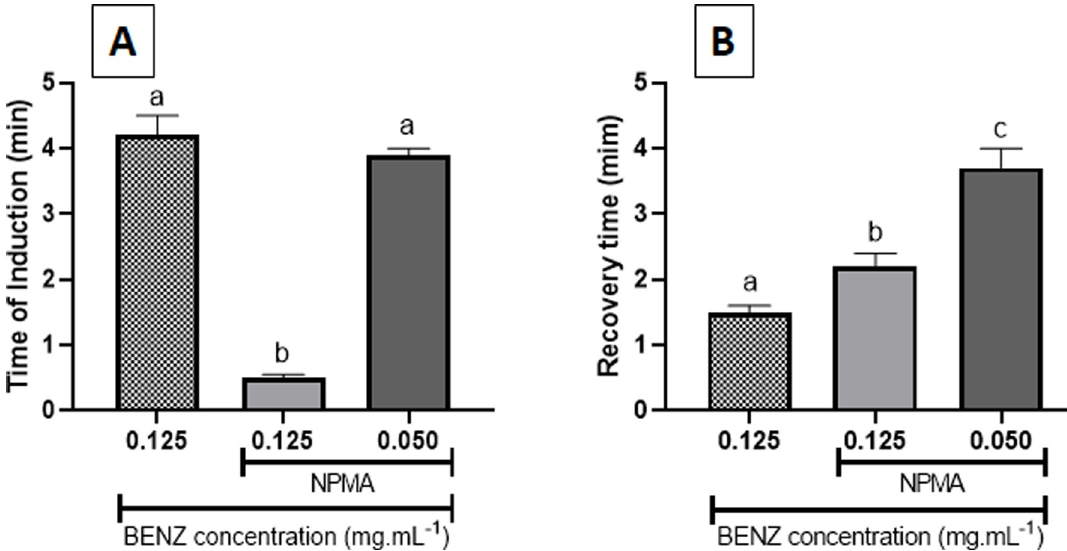
Fig 4. Evaluation of time for anesthesia induction and recovery of zebrafish adults exposed to BENZ and NPMA. (A) Anesthetic induction time (B) Recovery time of zebrafish adults.